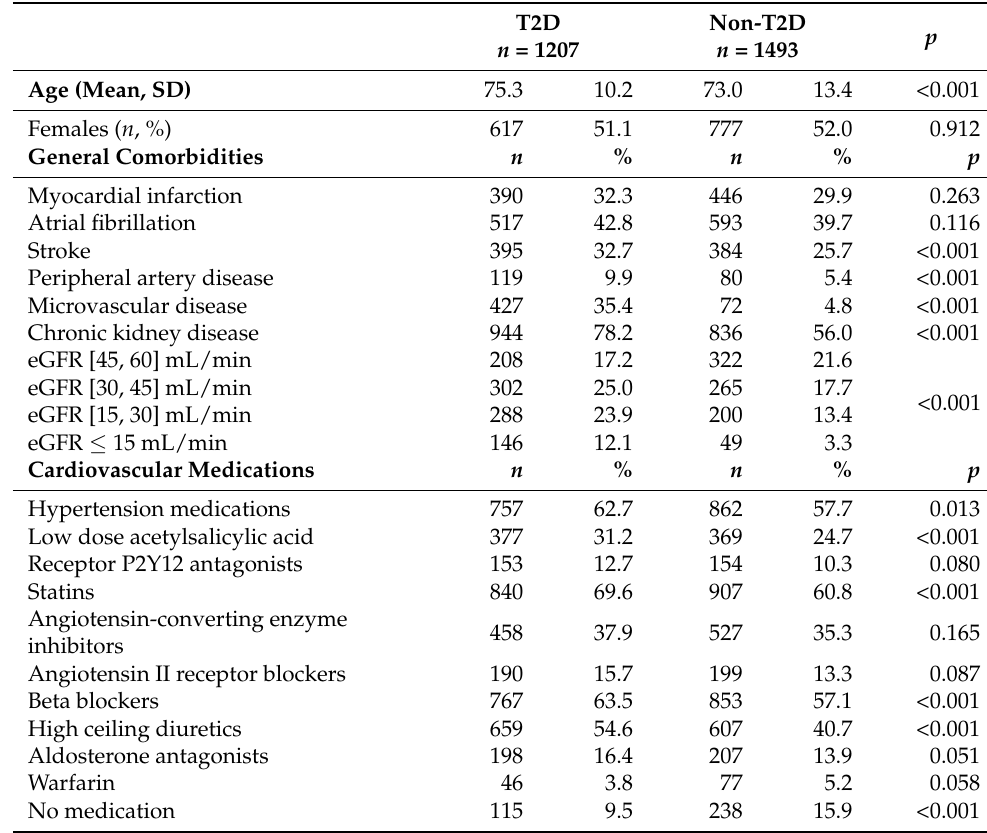
Figure 3. The prevalence of heart failure in Type 2 Diabetes Mellitus patients per heart failure subtype and age group. HFrEF, heart failure with a reduced ejection fraction; HFnrEF, heart failure with a non-reduced ejection fraction. Table 4. Comorbidities and cardiovascular medications of heart failure patients with and without type 2 diabetes